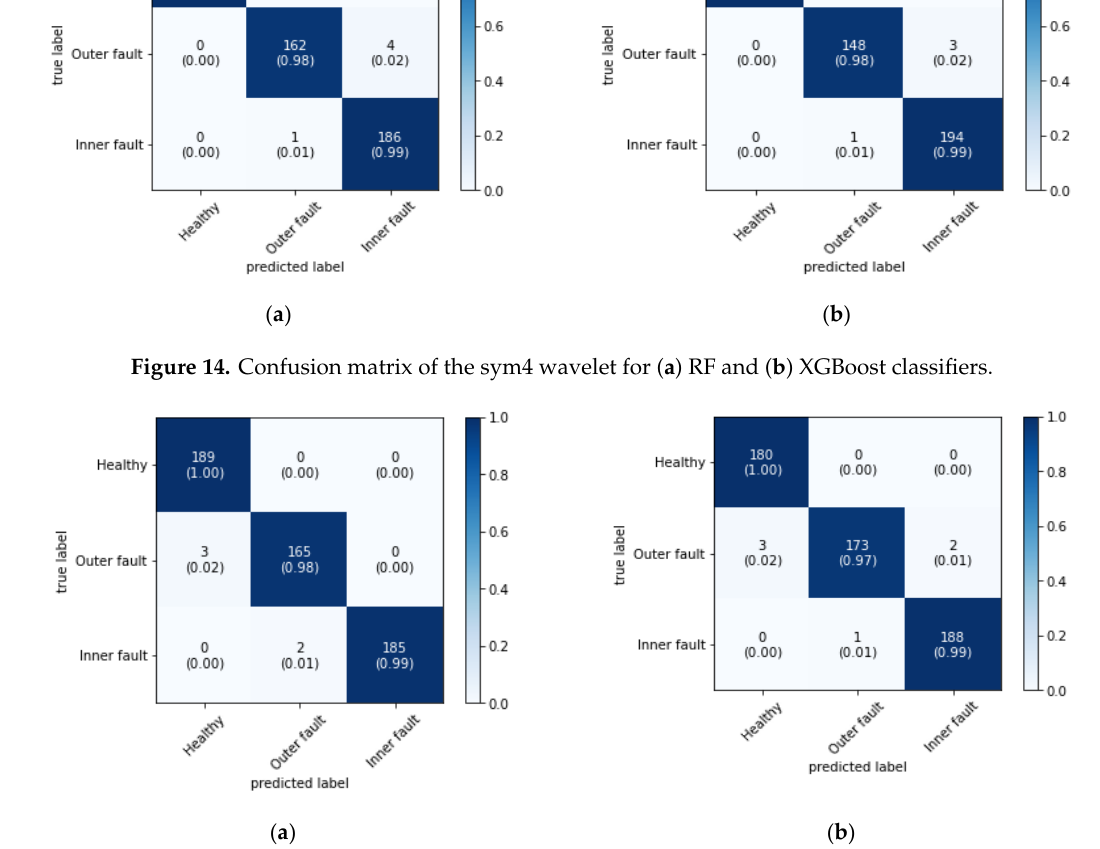
Figure 15. Confusion matrix of the Haar wavelet for ( a ) RF and ( b ) XGBoost classifiers.